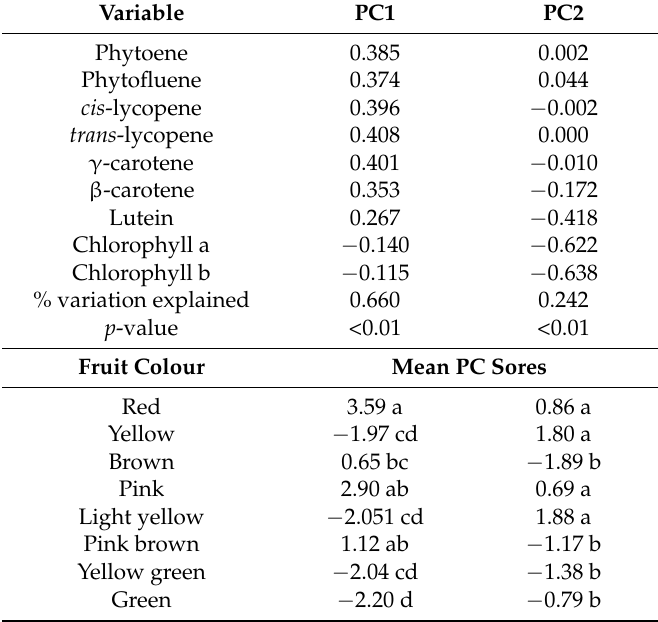
Table 3. Component loading biochemical (carotenoids and chlorophylls) concentrations and mean PC scores of eight different fruit color phenotypes of tomato in the segregating F 2 population as determined by principal component analysis